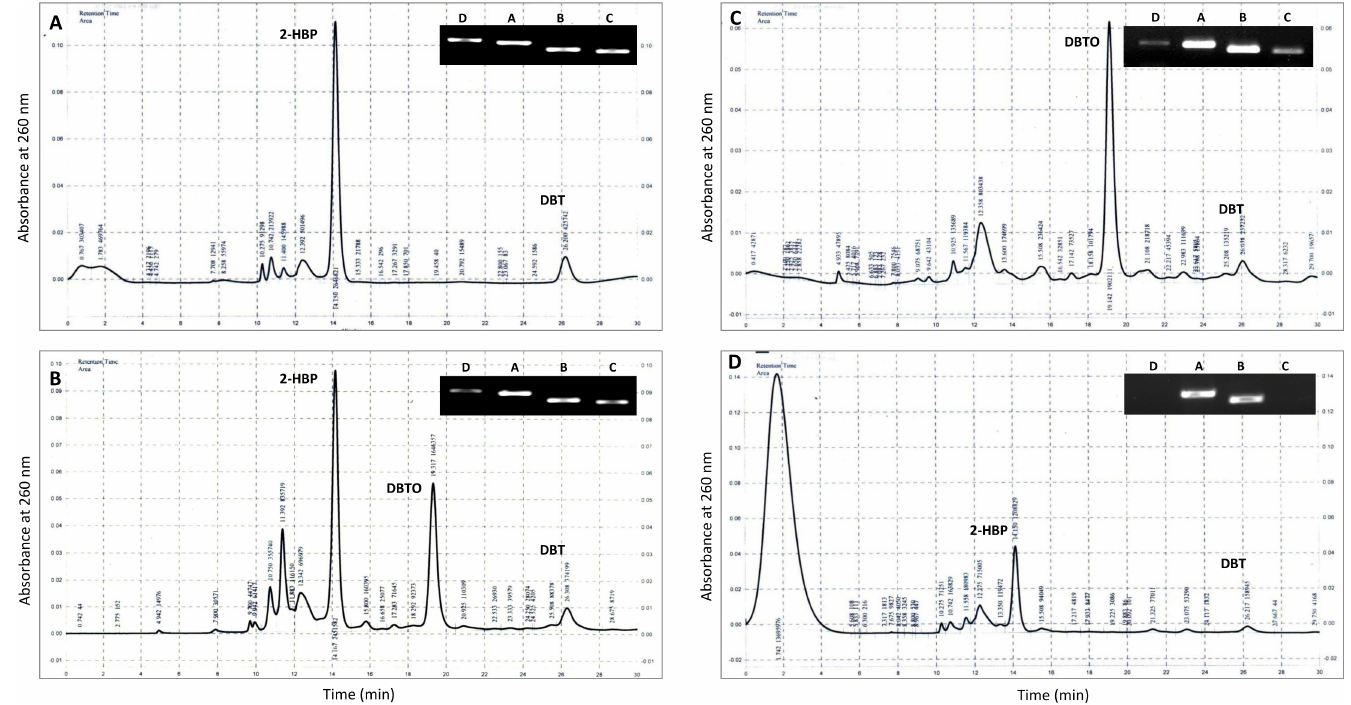
Fig 5. Chromatogram showing the DBT desulfurization after 10 days of growth with different MTCC strains (a) Rhodococcusrhodochrous (3552), (b) Artrobacter sulfureus (3332), (c) Gordonia rubropertincta (289) and (d) Rhodococcus erythropolis